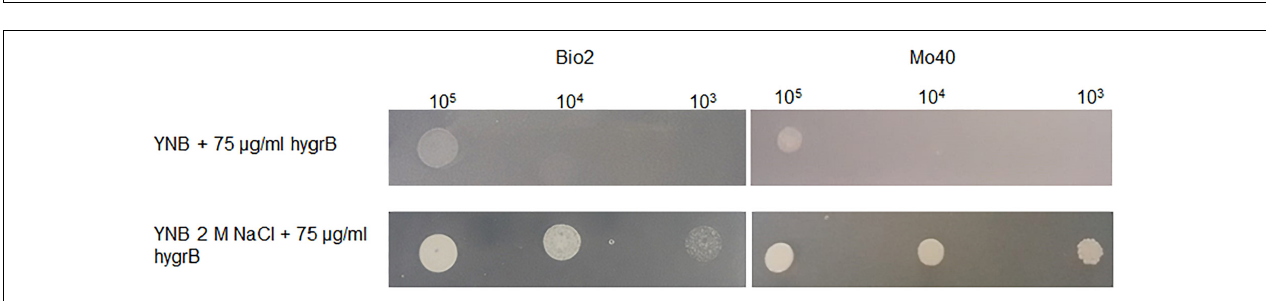
alters the membrane permeability to cationic compounds, due to an acquired level of